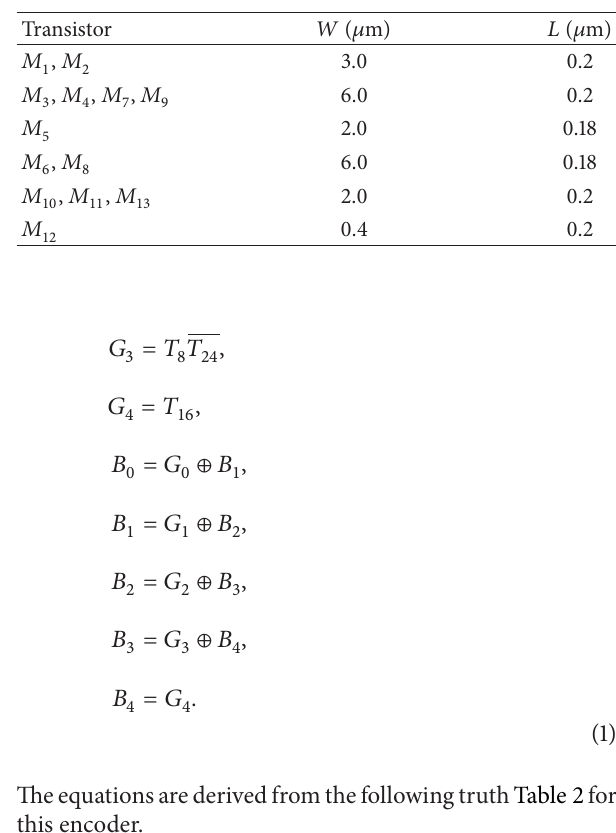
Table 1: Comparator schematic transistor aspect